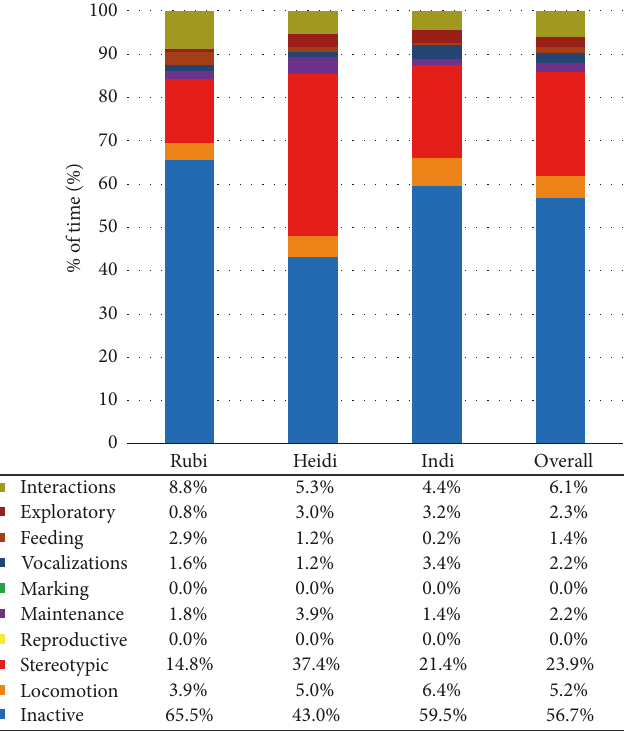
Figure 5: Time budgets for each female for Whipsnade Zoo in 2015. Data values are included to show exact percentages of time for each behavior class.